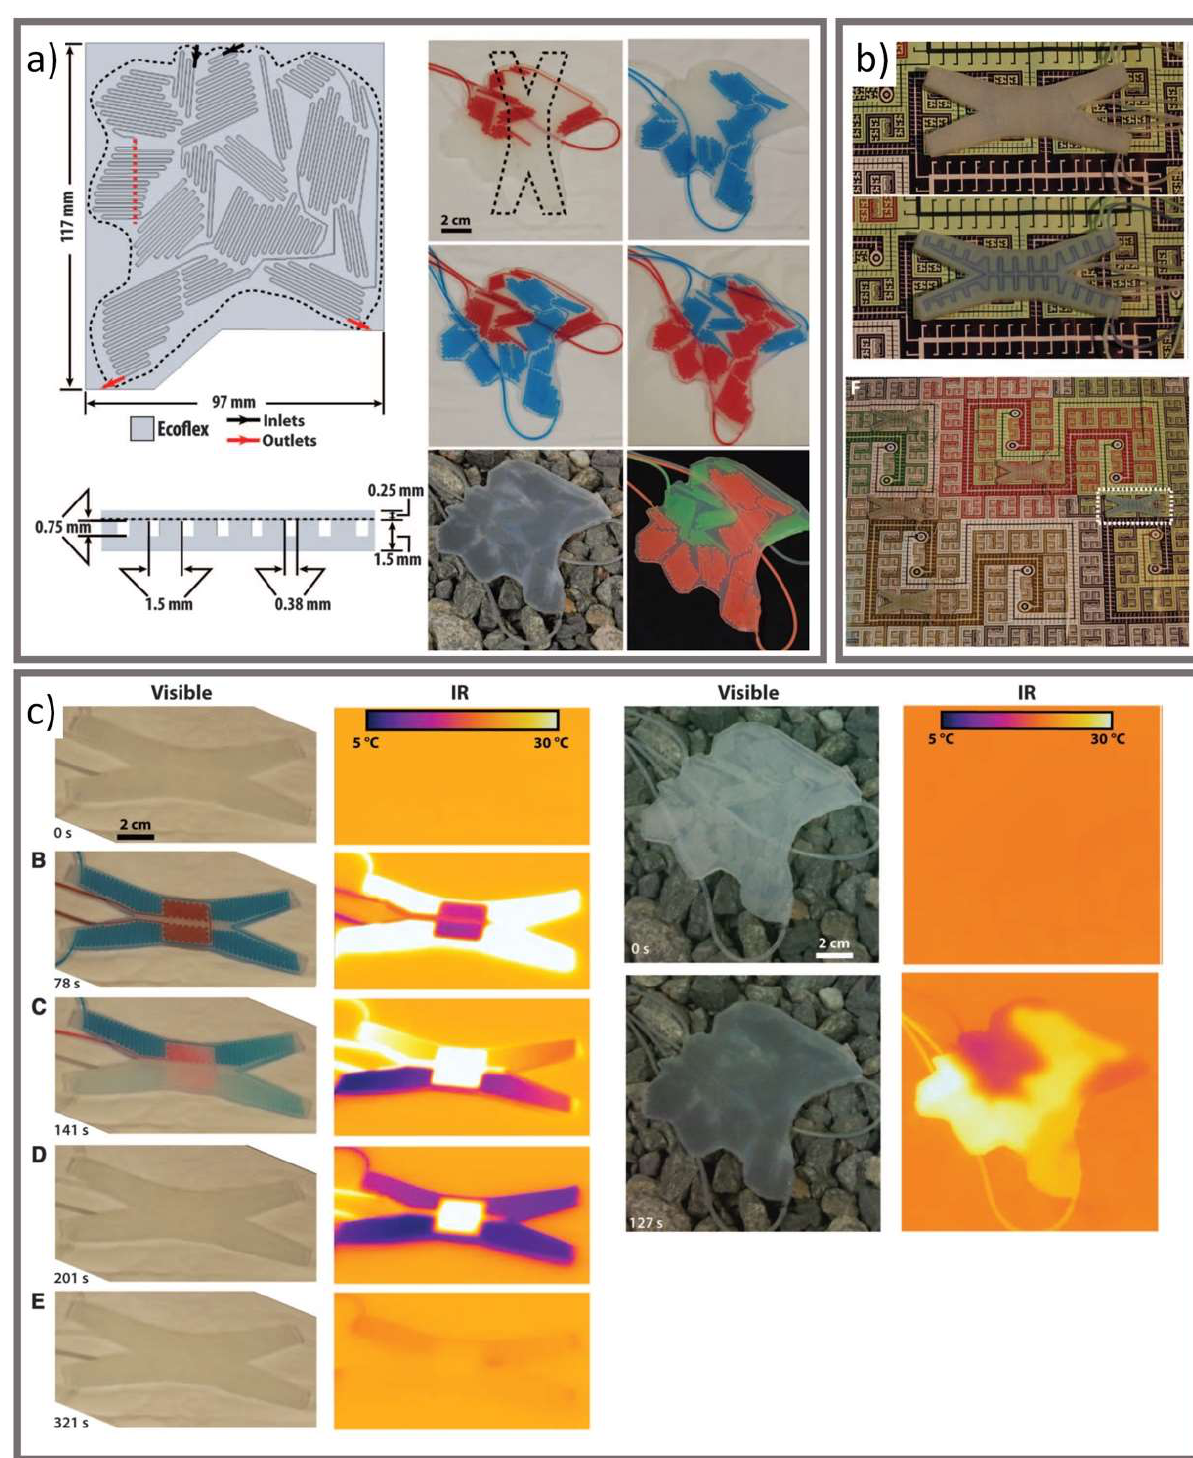
Figure 8. ( a ) The design of a soft robot device with internal microfluidic patterns. ( b ) The device can change its apparent color through pumping a dye solution or colored pigment that matches the environment making it invisible to the naked eye, ( c ) or can change its IR appearance through pumping warm and cool liquid (republished from [60] with permission of American Association for the Advancement of Science; permission conveyed through Copyright Clearance Center, Inc.).